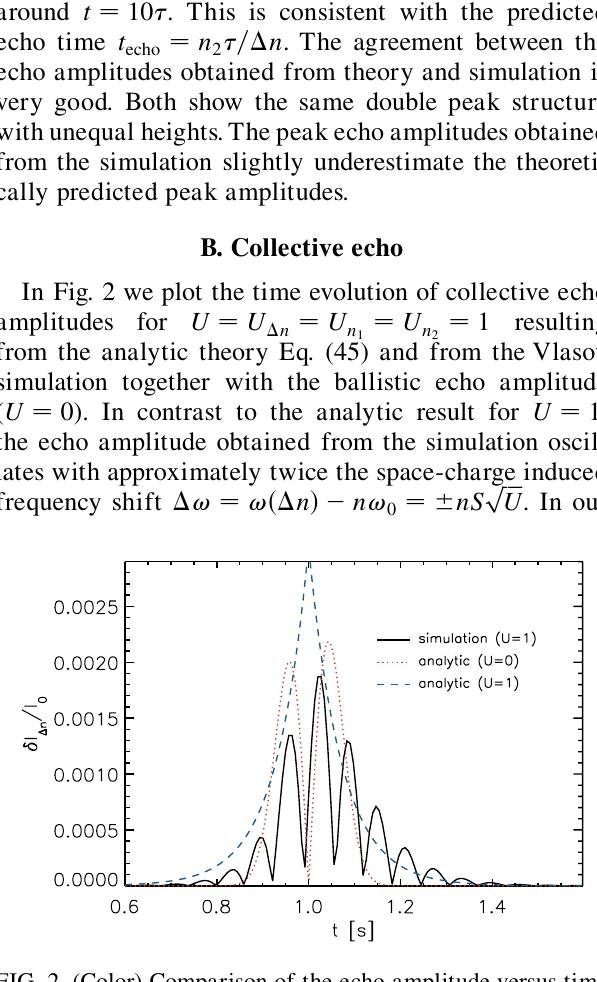
FIG. 2. (Color) Comparison of the echo amplitude versus time obtained from the simulation (solid line), the analytic ballistic echo theory (red dotted line), and from the analytic collective echo theory (blue dashed line) for U (cid:2) 1 and (cid:6) (cid:2) 0 : 1 s